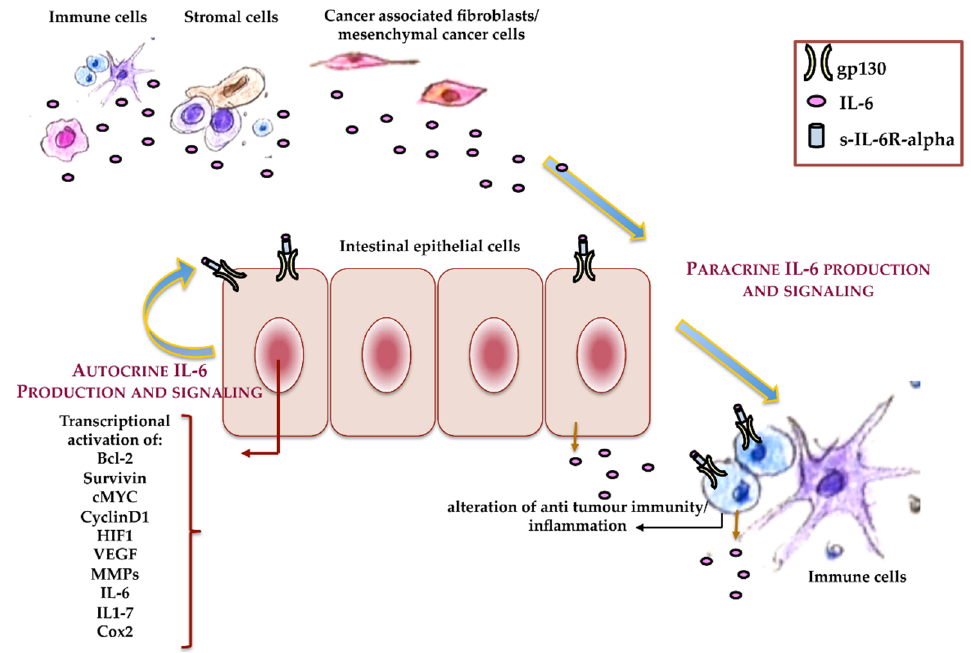
Figure 3. Autocrine and paracrine IL-6. Schematic representation of the roles that autocrine and paracrine IL-6 play during colorectal cancer (CRC) onset and progression.